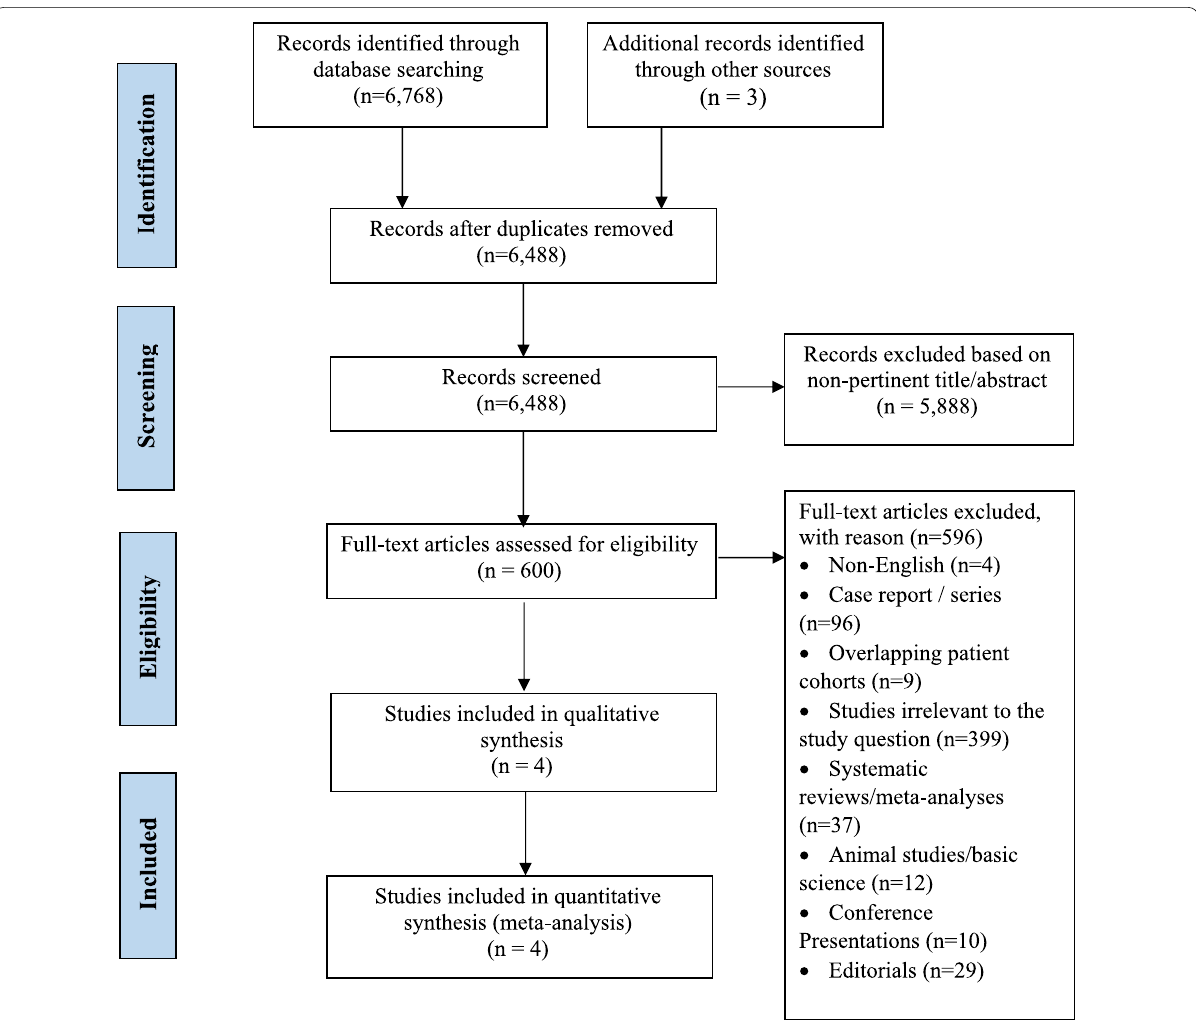
Table 1 Summary of included studies